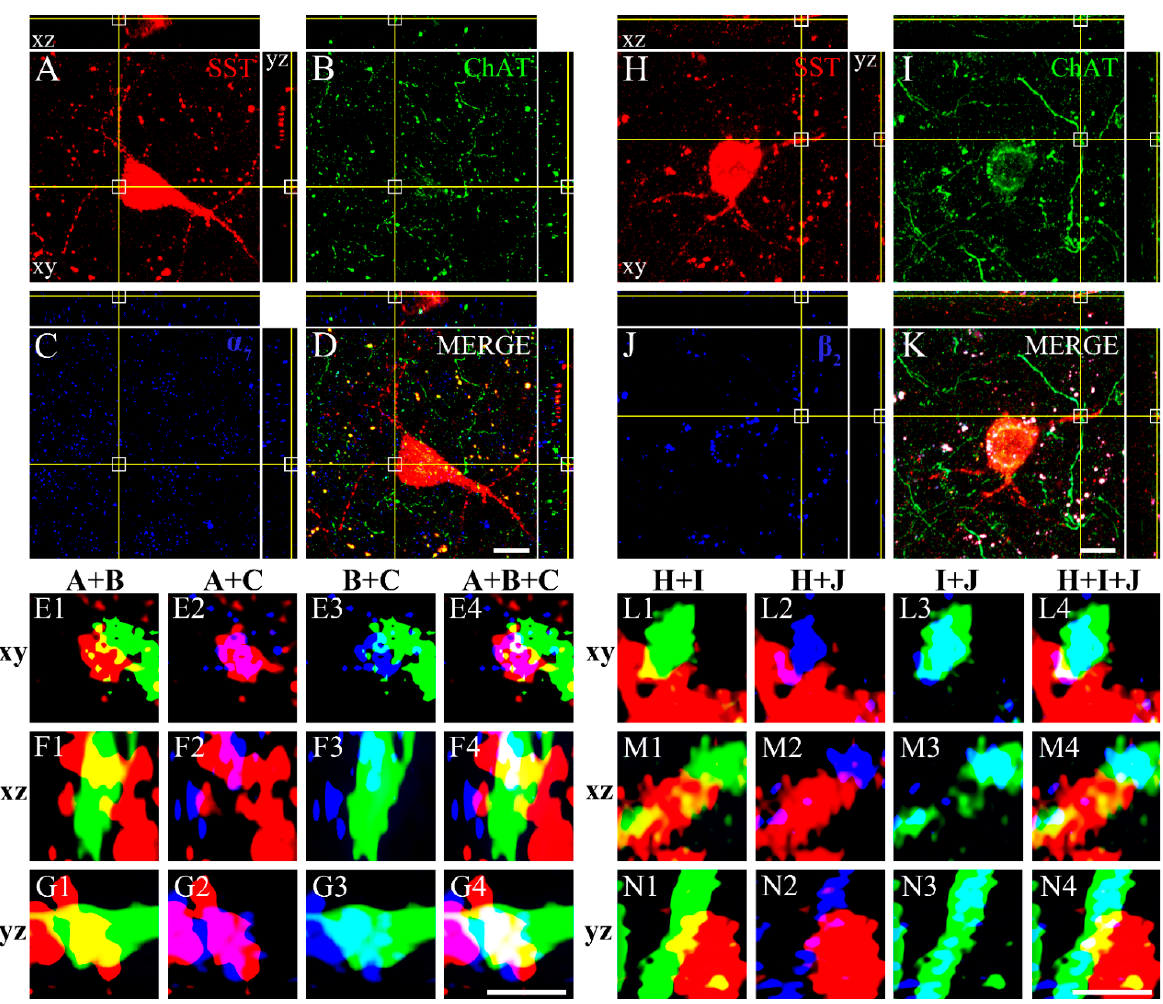
Figure 5. Triple-labeled fluorescence photomicrographs of SST neurons with ChAT-IR fibers and nAChRs. Orthogonal view of a confocal z-stack image of the SST neurons (red, A , H ), ChAT-IR fibers (green, B , I ), α 7 nAChRs (blue, false color of infrared fluorescence, C ), merged image of SST neurons with ChAT-IR fibers and α 7 nAChRs ( D ), β 2 nAChRs (blue, false color of infrared fluorescence, J ), and merged image of SST neurons with ChAT-IR fibers and β 2 nAChRs ( K ). High-power images in crosshair from the xy ( E1 – E4 ), xz ( F1 – F4 ), and yz ( G1 – G4 ) planes from A–D, respectively. High- power images in crosshair from the xy ( L1 – L4 ), xz ( M1 – M4 ), and yz ( N1 – N4 ) planes from H to K, respectively. ( E1 , F1 , G1 ) Merged images of SST neurons ( A ) and ChAT-IR fibers ( B ) in the xy, xz, and yz planes, respectively. ( E2 , F2 , G2 ) Merged images of SST neurons and α 7 nAChRs immunopuncta in the xy, xz, and yz planes, respectively. ( E3 , F3 , G3 ) Merged images of ChAT-IR fibers and α 7 nAChRs immunopuncta in the xy, xz, and yz planes, respectively. ( E4 , F4 , G4 ) Merged images of SST neurons, ChAT-IR fibers, and α 7 nAChRs immunopuncta in the xy, xz, and yz planes, respectively. ( L1 , M1 , N1 ) Merged images of SST neurons ( H ) and ChAT-IR fibers ( I ) in the xy, xz, and yz planes, respectively. ( L2 , M2 , N2 ) Merged images of SST neurons and β 2 nAChRs immunopuncta in the xy, xz, and yz planes, respectively. ( L3 , M3 , N3 ) Merged images of ChAT-IR fibers and β 2 nAChRs immunopuncta in the xy, xz, and yz planes, respectively. ( L4 , M4 , N4 ) Merged images of SST neurons, ChAT-IR fibers, and β 2 nAChRs immunopuncta in the xy, xz, and yz planes, respectively. SST, somatostatin; ChAT, choline acetyltransferase; α 7 , α 7 nicotinic acetylcholine receptor; β 2 , β 2 nicotinic acetylcholine receptor. Scale bar = 10 ( A – D , H – K ) and 1 μ m ( E1 – G4 , L1 – N4 ). 4. Discussion The present study showed that SST neurons were mainly distributed in layer V of the Mongolian gerbil VC and showed various morphologies. Our results also showed